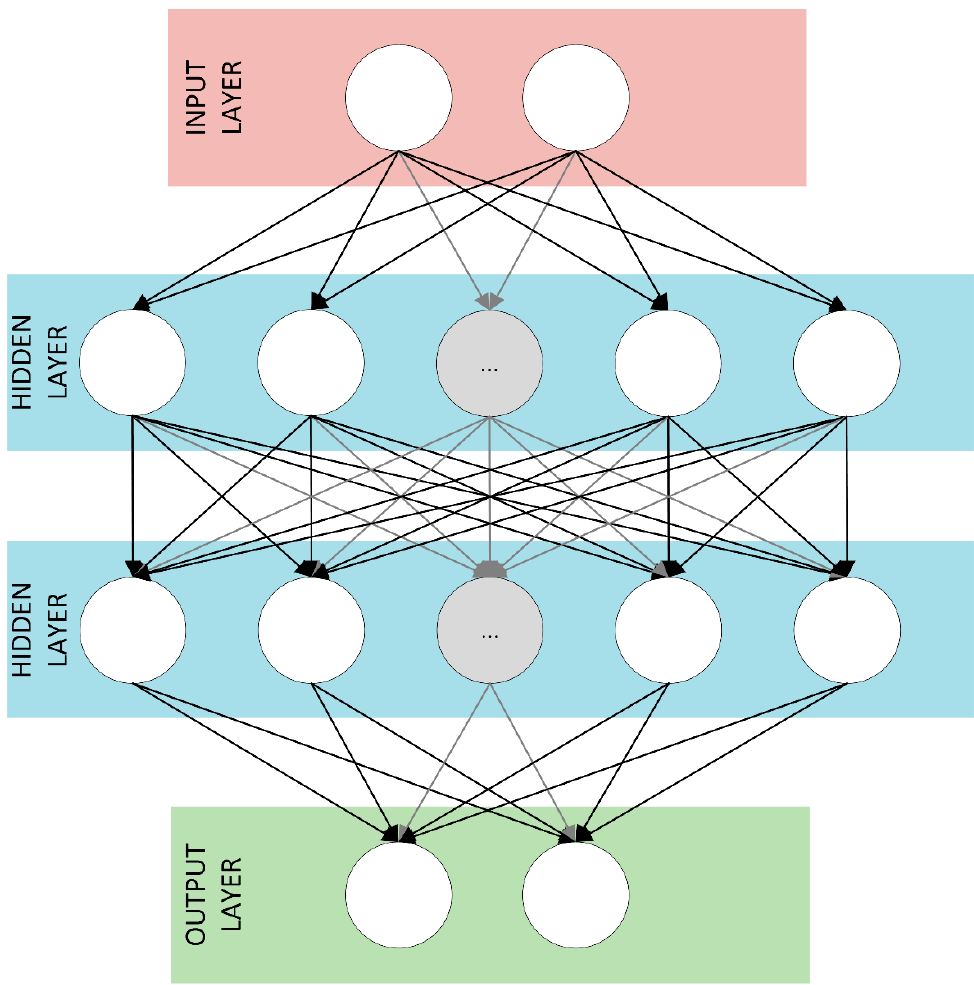
Figure 1. Architecture of the proposed Deep Feedforward Neural Network (DFNN). Table 1. Results of the classification e ffi